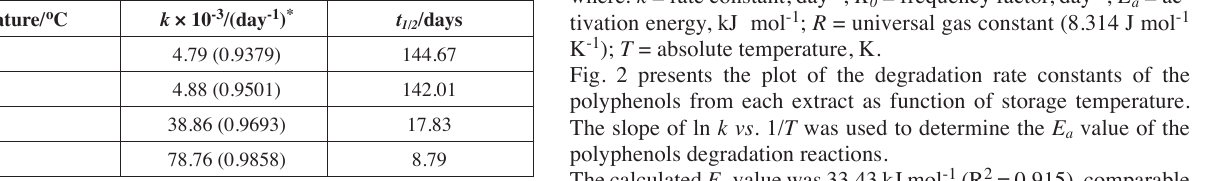
Tab. 1: Effect of temperature on the kinetic parameters of polyphenols de- gradation in Cornelian cherries extracts Temperature/ o